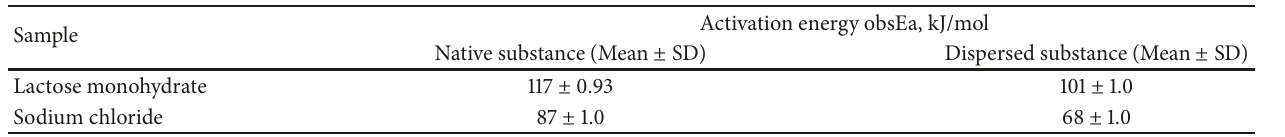
Figure 5: Dependence of the infusoria mortality rate on temperatureand dispersity for the aqueous solutions of 1% sodium chloride in direct (left graph) and Arrhenius coordinates (right graph). (a) Native sodium chloride and (b) dispersed sodium chloride. n ≥ 5; a < 0.05. Table 2: The S. ambiguum ligand-induced death activation energy for the lactose monohydrate and sodium chloride samples solutions (n = 15, ∗ p <